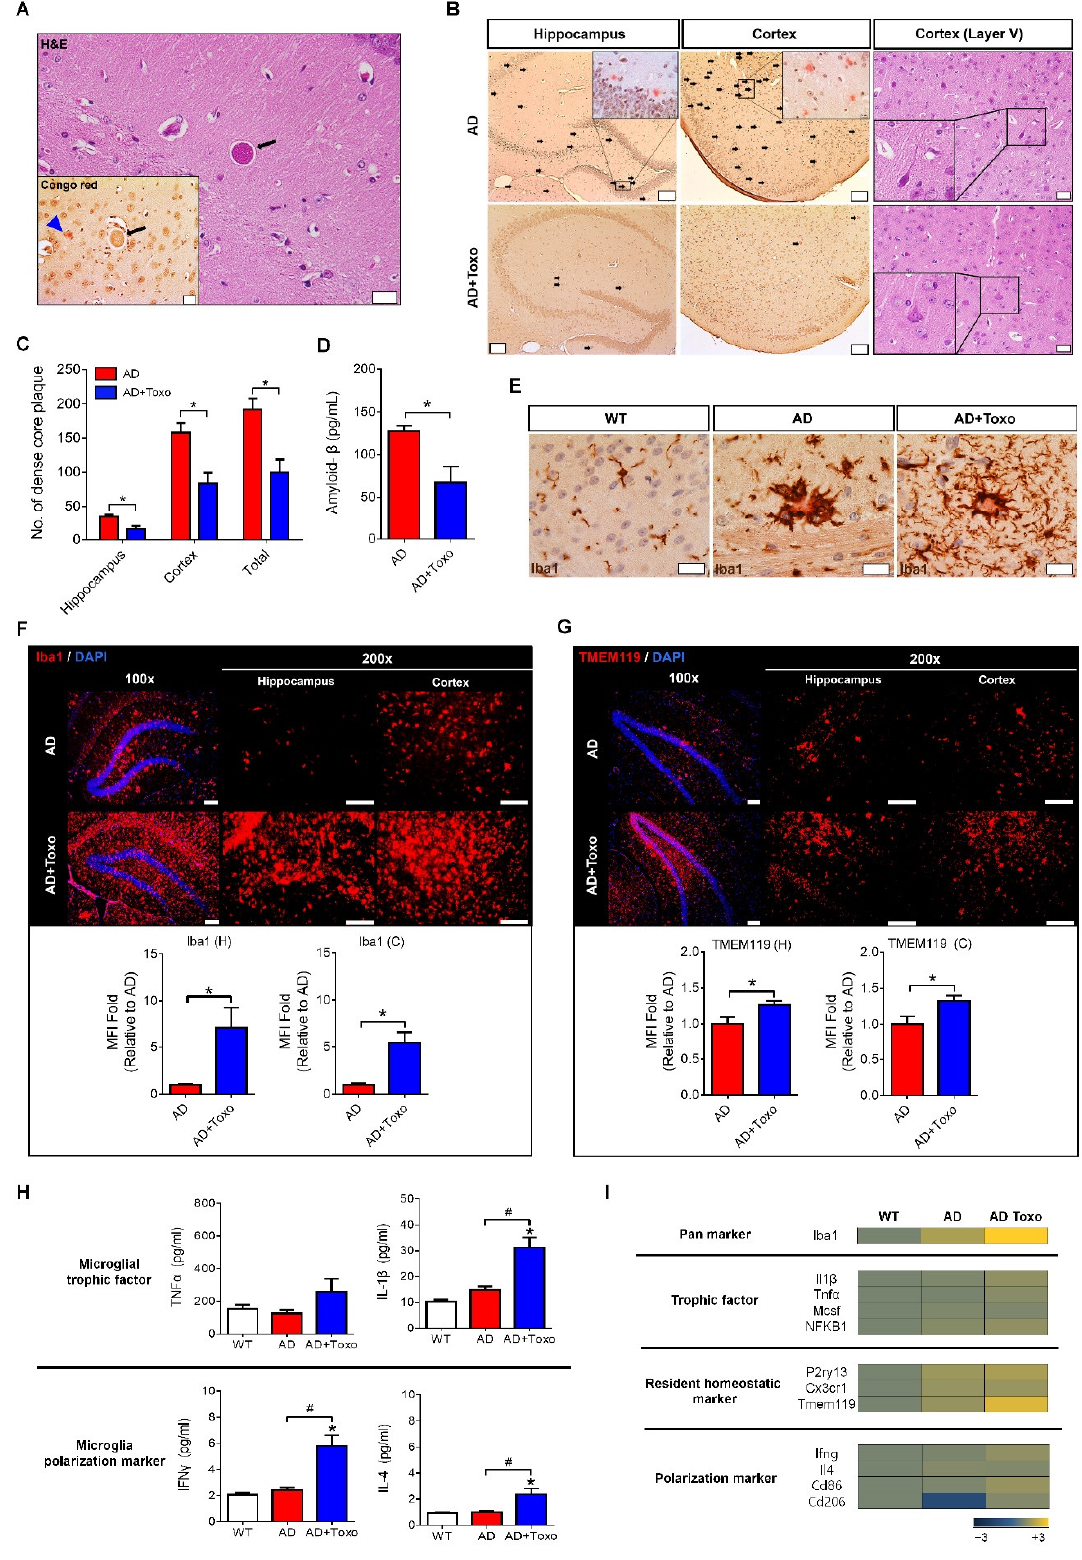
Figure 2. Reduction of A β plaques and microglial proliferation in T. gondii -infected 5XFAD mouse brain. ( A ) A T. gondii cyst (black arrow) and stained amyloid plaque (blue arrow head) in a brain section (H&E and Congo red staining) at 40 weeks PI. Scale bar; 20 µm. ( B ) Dense core plaques (black spots) stained using Congo red dye (scale bar; 100 µm) and acidophilic neurons (black quadrangle) in cortical layer V (scale bar; 20 µm). ( C ) The number of dense core plaques counted